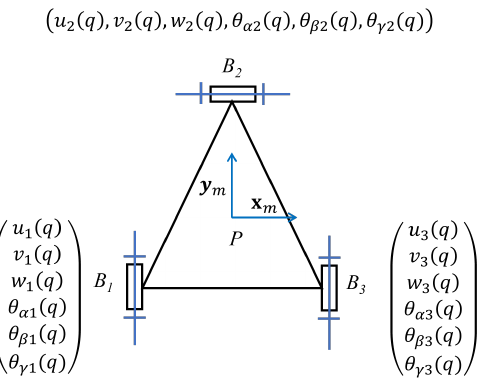
Figure 7. Parametrization of Tripteor mobile platform movement.